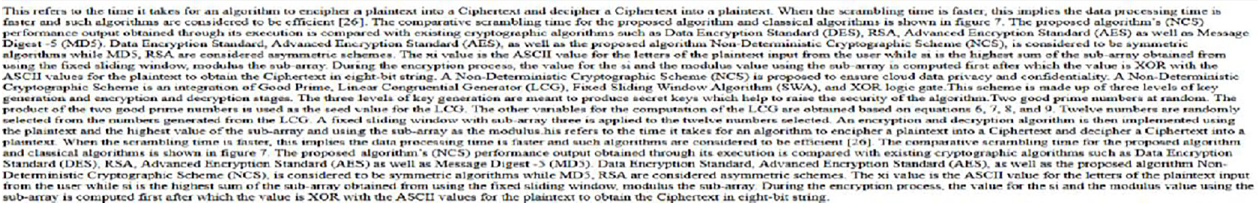
Fig 11. Plaintext to be encrypted with a file size of